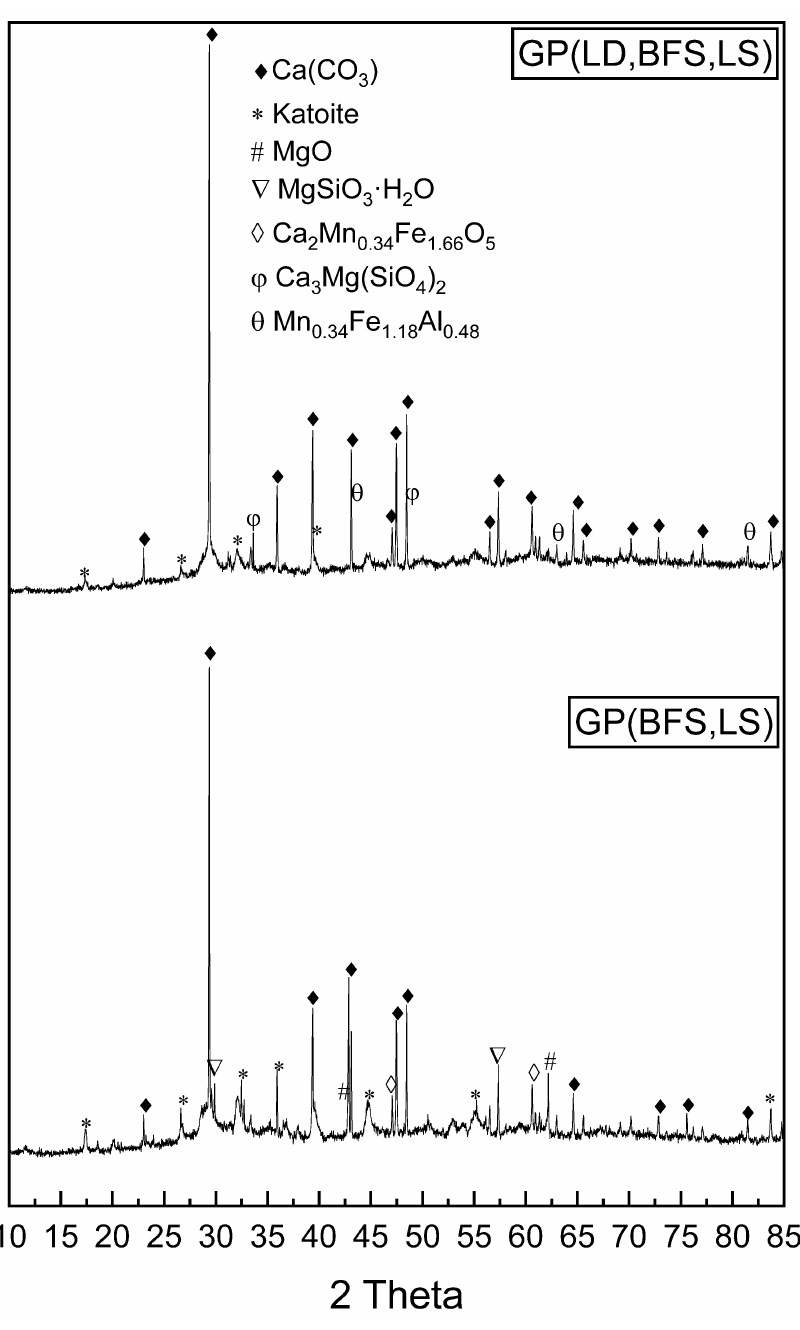
Figure 2. XRD patterns of geopolymers GP (BFS, LS) and GP (LD, BFS, LS).